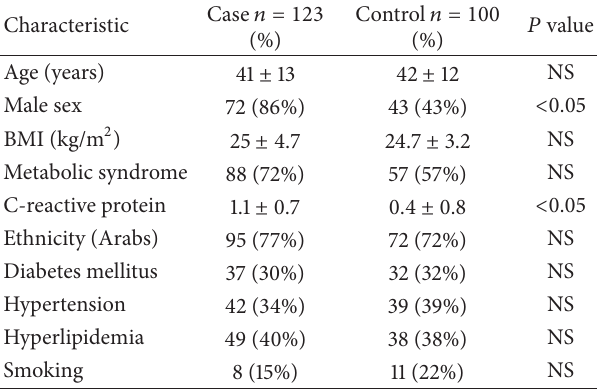
Table 1: Demographic, laboratory, and clinical data comparing NASH group and control